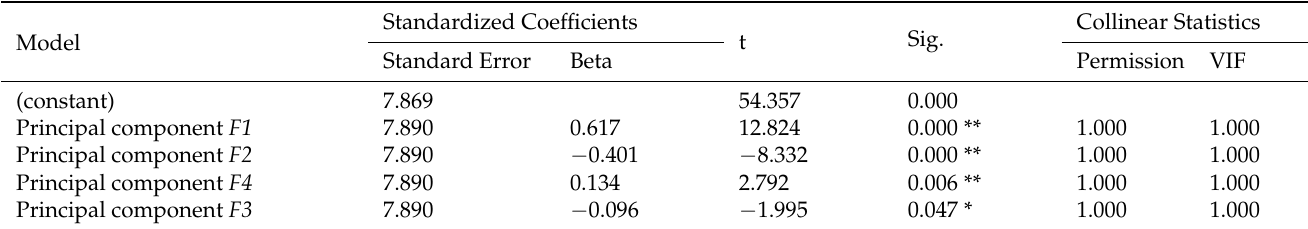
Table 11. Coefficient in the final model of the path distance